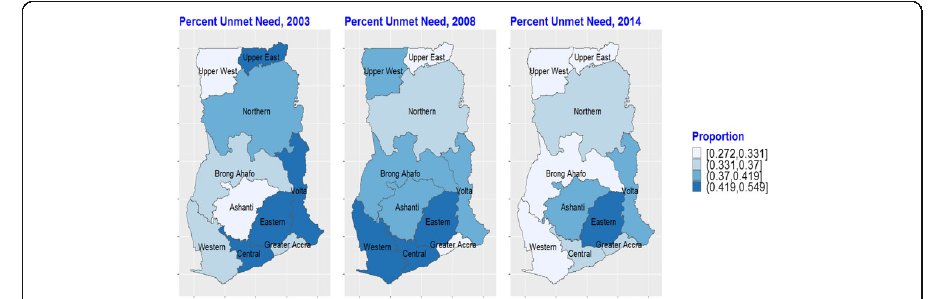
Fig. 1 Spatial variations in unmet need for family planning in Ghana: 2003 –